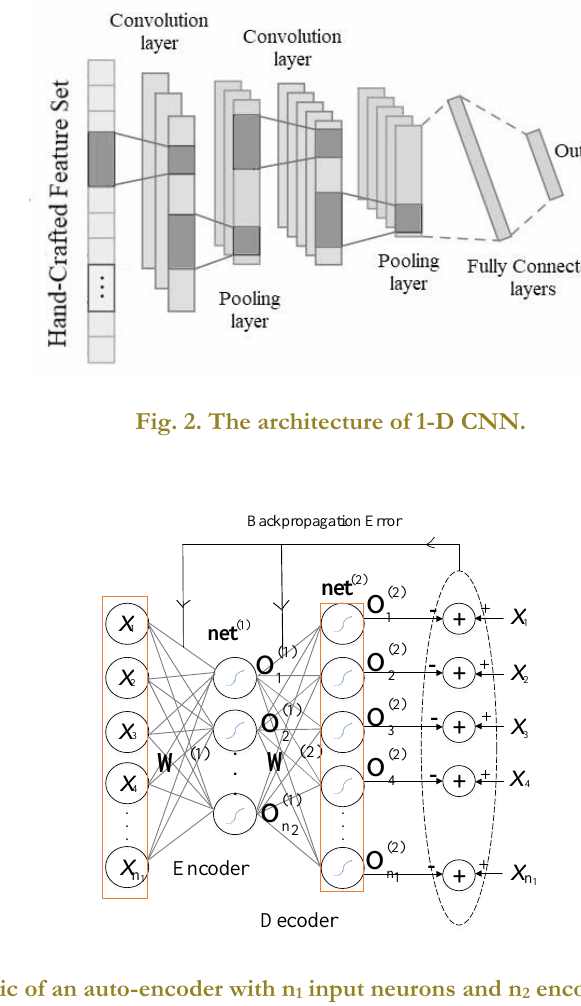
Fig. 3. Schematic of an auto-encoder with n 1 input neurons and n 2 encoder